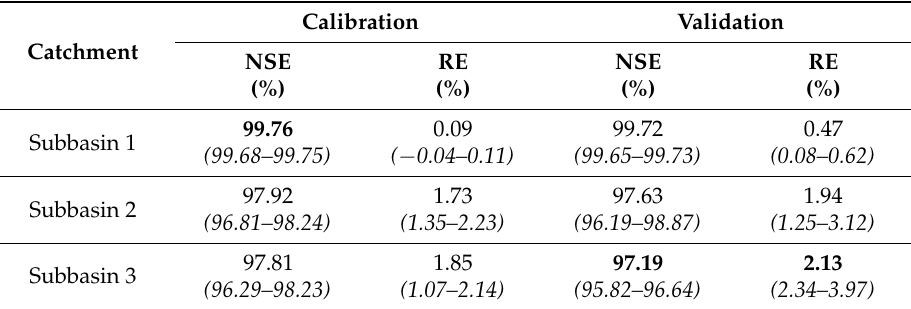
Table 2. Performance measures for ABCM ensemble